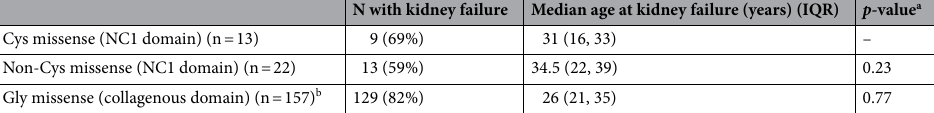
N with kidney failure Median age at kidney failure (years) (IQR) p -value a Cys missense (NC1 domain) (n =